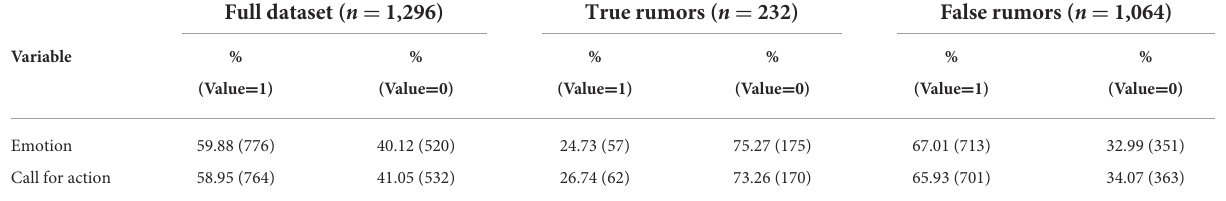
TABLE 5 Descriptive statistics of information affectiveness.